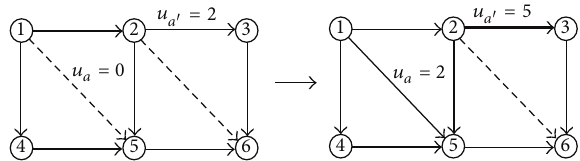
Figure 2: Neighboring function based on two link levels being